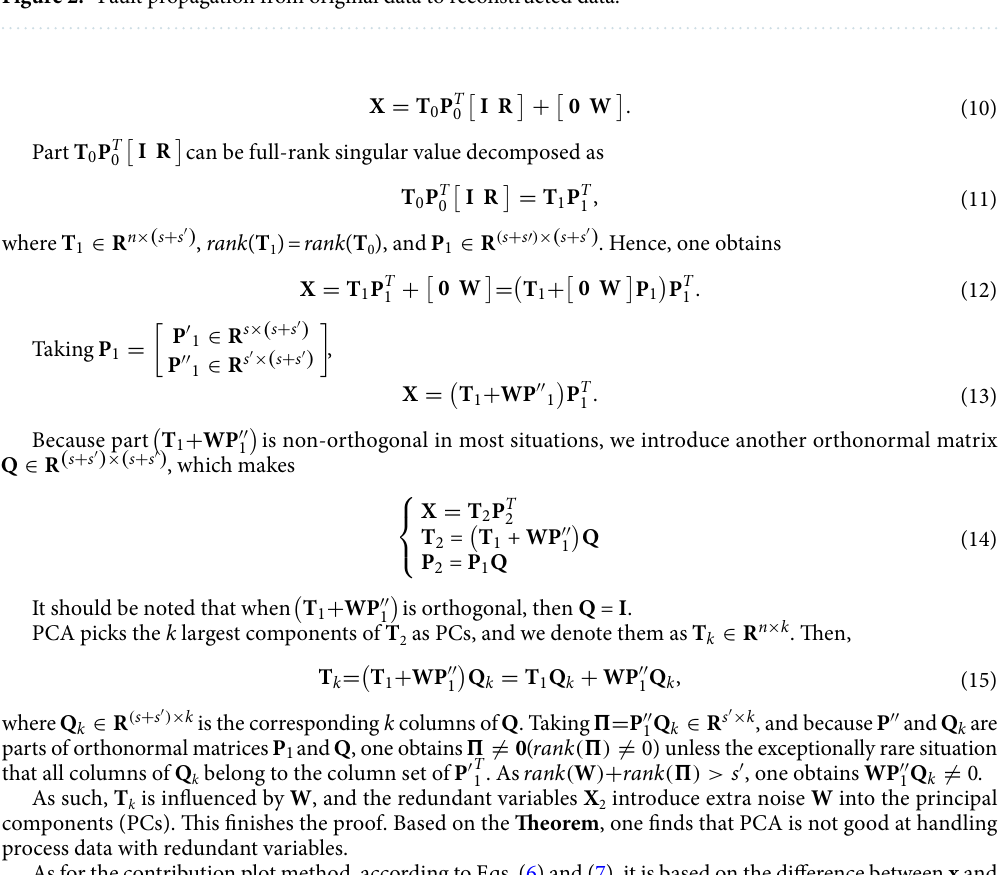
Figure 2. Fault propagation from original data to reconstructed